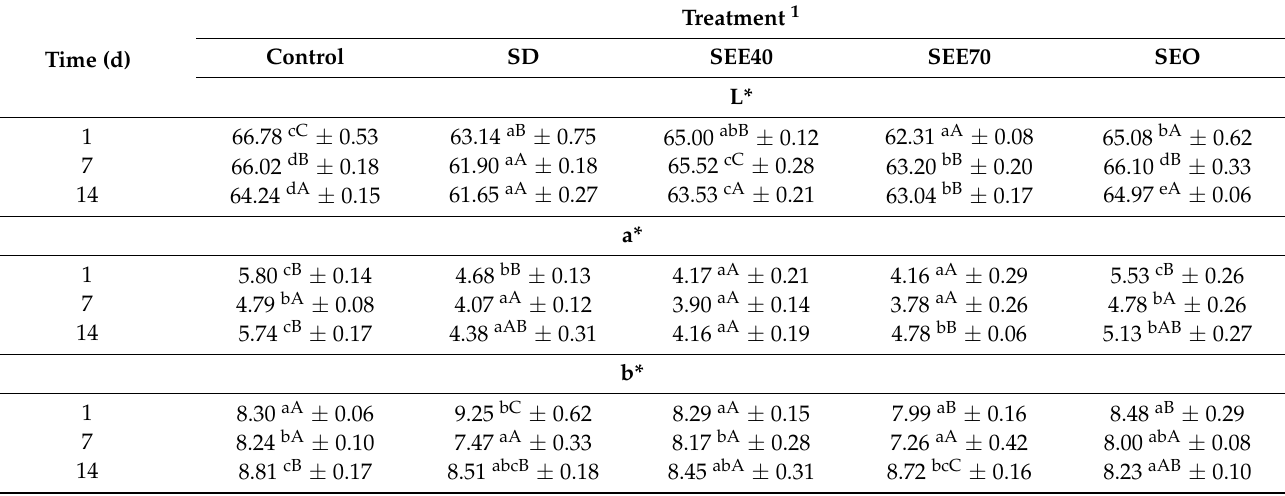
Table 3. Changes in the color parameters of chicken meatballs containing MSM from chickens during refrigerated storage (mean value ± standard deviation; n =